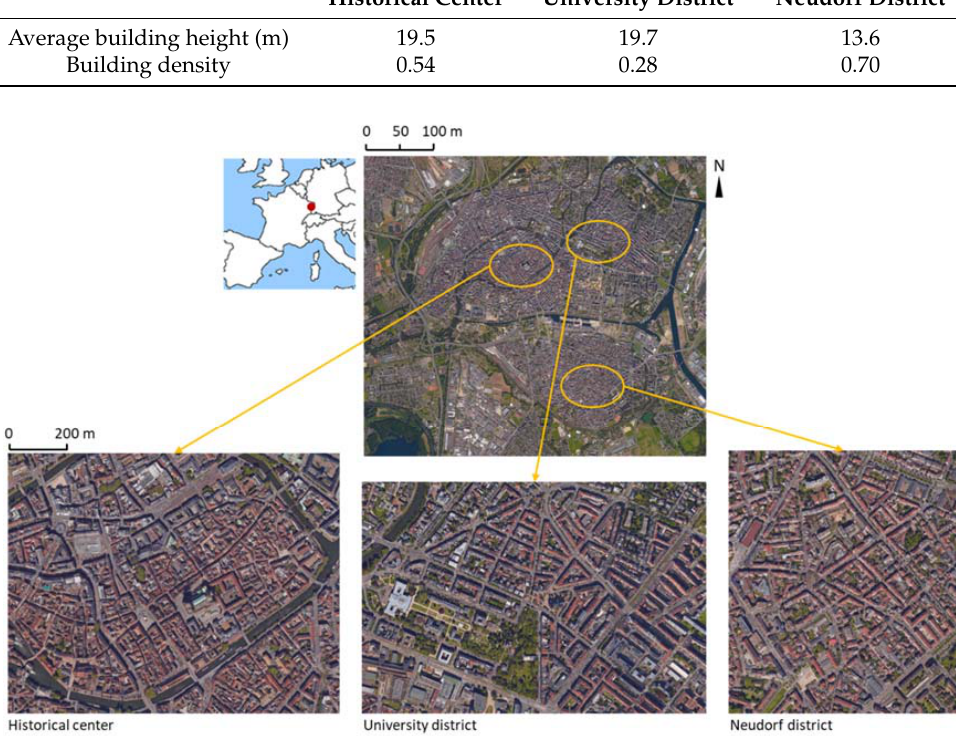
Figure 3. Strasbourg urban area ( top ) and the three districts used for land surface emissivity and temperature estimation ( bottom ).